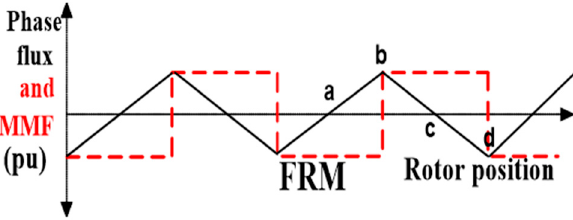
Figure 19. Variation of mmf and phase-flux variations with respect to rotor displacement [15].